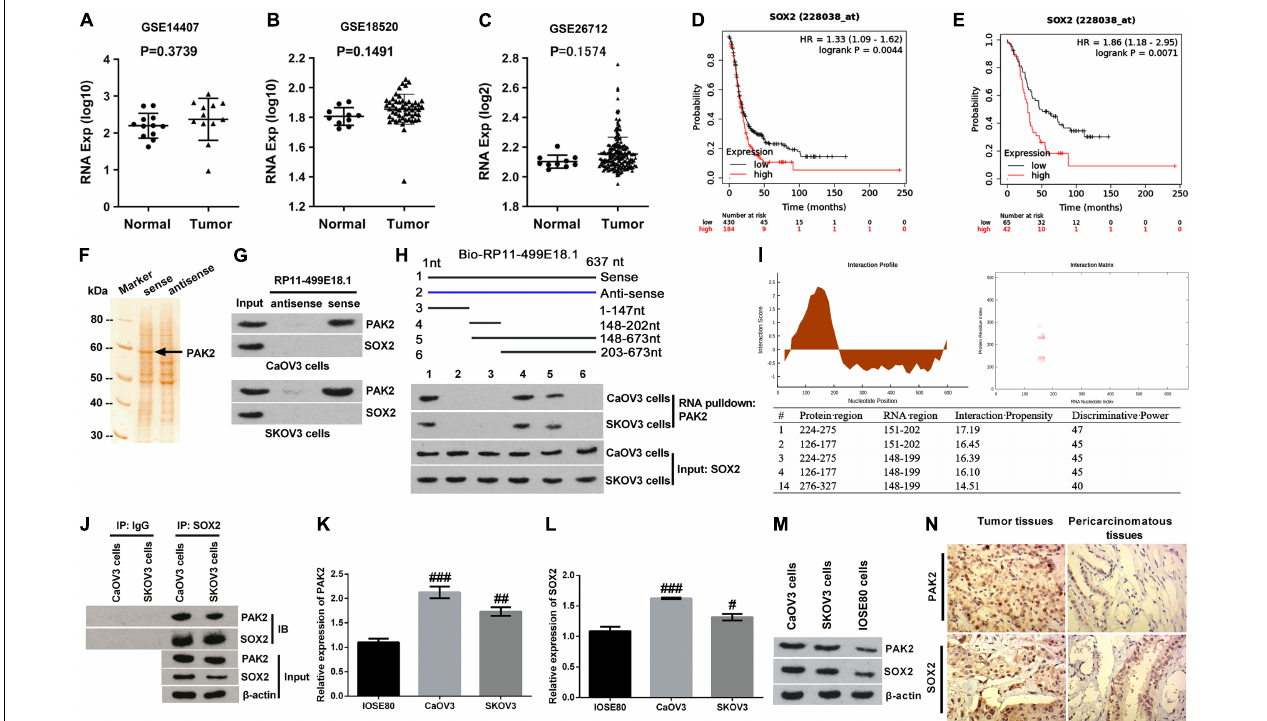
FIGURE 3 | Validation of the interactions among RP11-499E18.1, PAK2, and SOX2. (A–C) There was no significant difference of SOX2 expression between normal tissues and OC tissues. (D,E) High expression of SOX2 was closely associated with poor prognosis of OC patients. (F) The band located at 60 kDa was identified as PAK2. (G) RNA pulldown assay affirmed that there was an interaction between RP11-499E18.1 and PAK2. (H,I) Domain mapping assay and catRAPID database analysis confirmed that there was a strong binding effect between the 150–200 bp region of lncRNA RP11-49E18.1 and the 126–177/245–275 amino acid region of PAK2. (J) There was an interaction between PAK2 and SOX2 in CaOV3 and SKOV3 cells. (K–M) The expression of PAK2 and SOX2 in CaOV3 and SKOV3 cells was notably higher than in IOSE80 cells. (N) The expression of PAK2 and SOX2 in OC tissues was much higher than in pericarcinomatous tissues. OC, ovarian cancer; PAK2, P21 (RAC1) activated kinase 2; SOX2, SRY-box transcription factor 2. # p < 0.05, ## p < 0.01, ### p < 0.001.